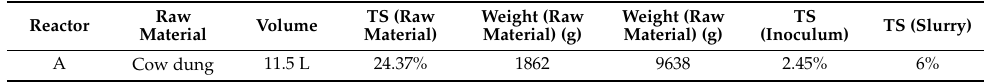
Table 2. Properties of raw materials for fermentation experiments.